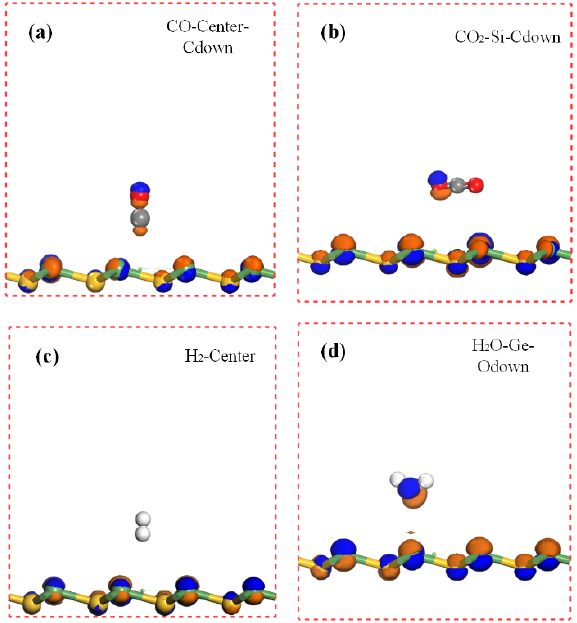
Figure 6. The charge density difference of ( a ) CO, ( b ) CO 2 , ( c ) H 2 , and ( d ) H 2 O adsorbed on SiGe monolayer (the contour lines in plots are drawn at 0.02 e/Å 3 intervals). The blue and brown areas represent accumulation and depletion of charge density.